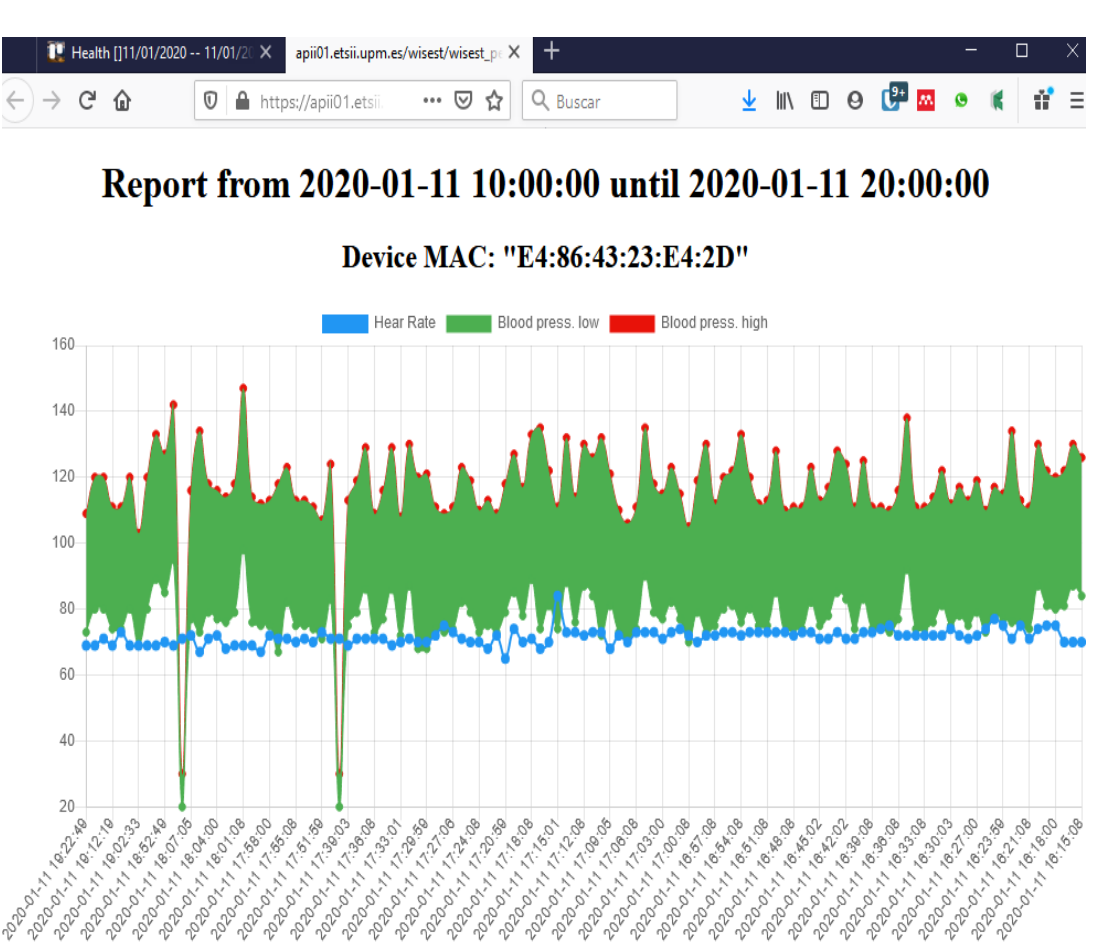
Figure 10. The graphical detailed view of the collected data at an individual